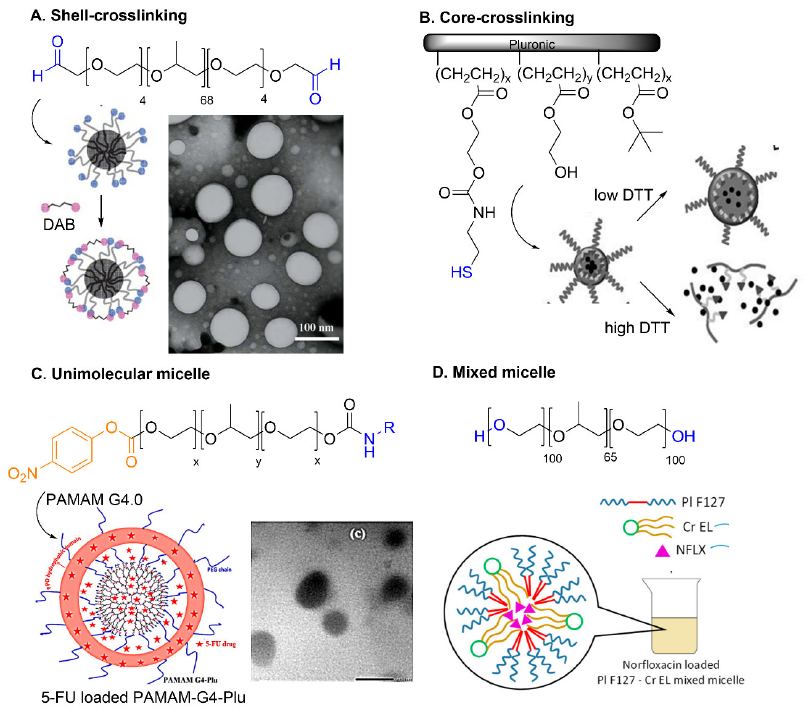
Figure 5. Diverse strategies to improve micelle stability. ( A ) Shell-crosslinking. Reprinted from [100], Copyright 2007, with permission from Elsevier. ( B ) Core-crosslinking. Reproduced from [102]. ( C ) Unimolecular micelle. Reprinted from [48], Copyright 2017, with permission from Elsevier. ( D ) Mixed micelle. Reprinted from [104].